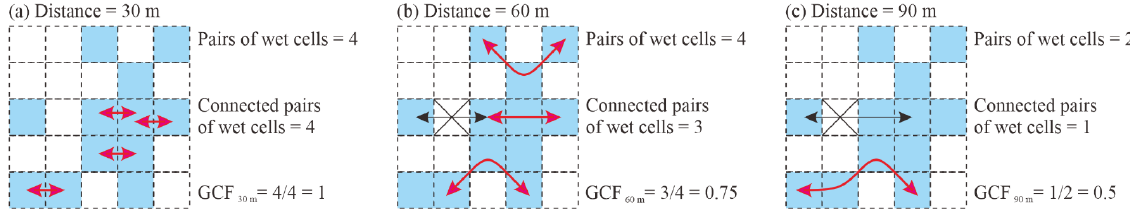
Figure 2. Example of how to calculate the geostatistical connectivity function (GCF) along the west–east (W–E) direction on the basis of the wet and dry binary state raster. The blue cells refer to wet cells, and the white cells refer to dry cells. The red lines with arrows mark the connection between pairs of wet cells, whereas the black lines with a symbol “×” and arrows mark the disconnection between pairs of wet cells. ( a ) Distance = 30 m, ( b ) Distance = 60 m, and ( c ) Distance = 90 m. Source: Figure reproduced from our previous paper [15].